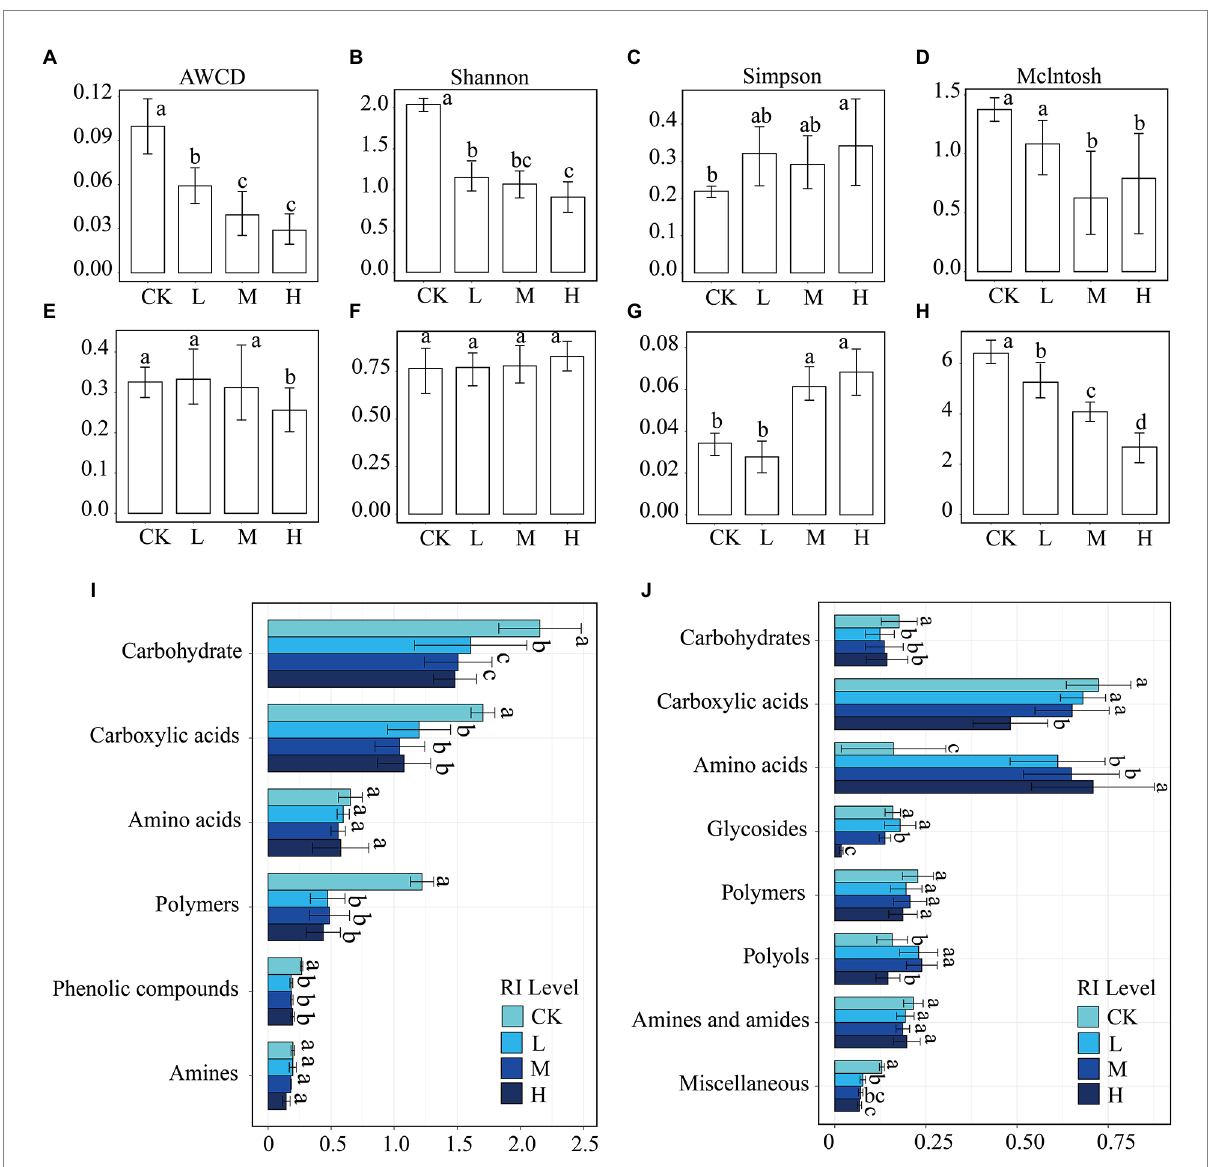
FIGURE 4 Metabolic profile of bacterial and fungal communities under different RI levels. Average well color development (AWCD), Shannon index, Simpson index, and McIntosh index of bacterial (A–D) and fungal (E–H) communities. Variability among RI levels of taxonomic carbon sources for bacteria (I) and fungi (J) . Different lowercase letters indicate significant differences among different RI levels ( p <